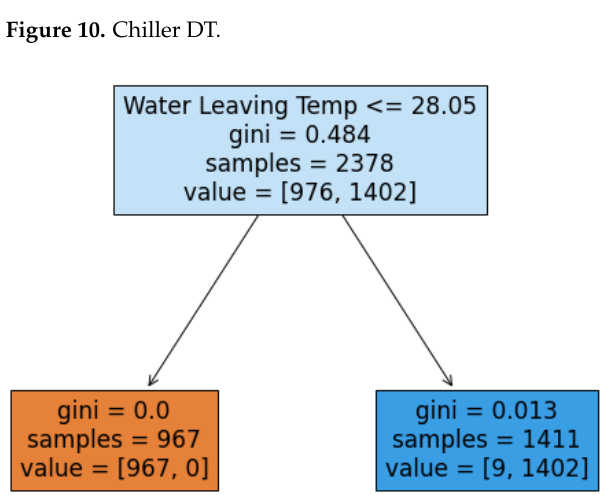
Figure 11. Cooling Tower DT.